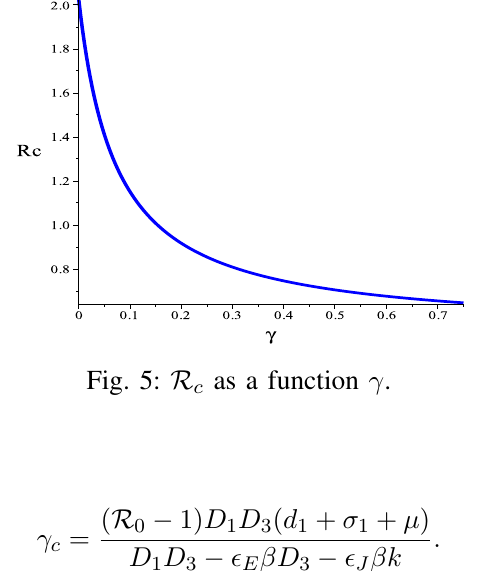
Fig. 5: R c as a function γ